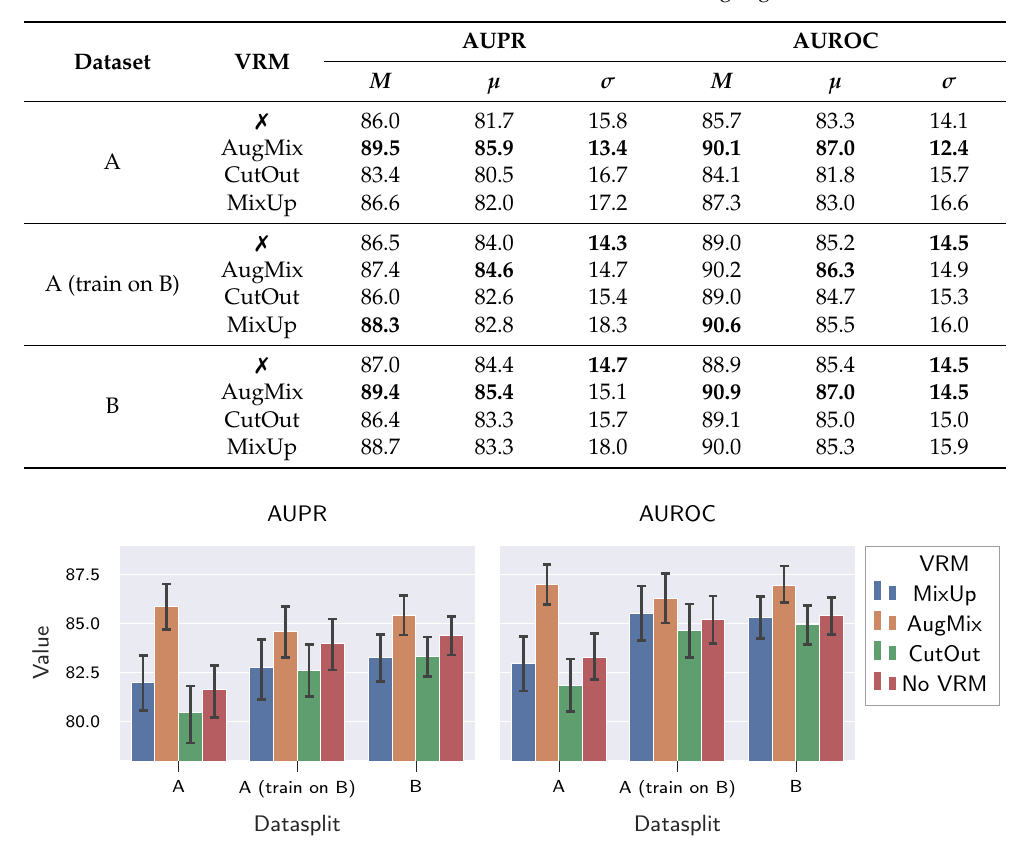
Table 6. Influence of dataset composition and VRM type on the performance of supervised fabric AD methods on unseen fabrics. Scores on the held-out fabrics are reported for a pre-trained EfficientNet- B0 fine-tuned with the HSC loss. Best scores within each dataset are highlighted in bold.